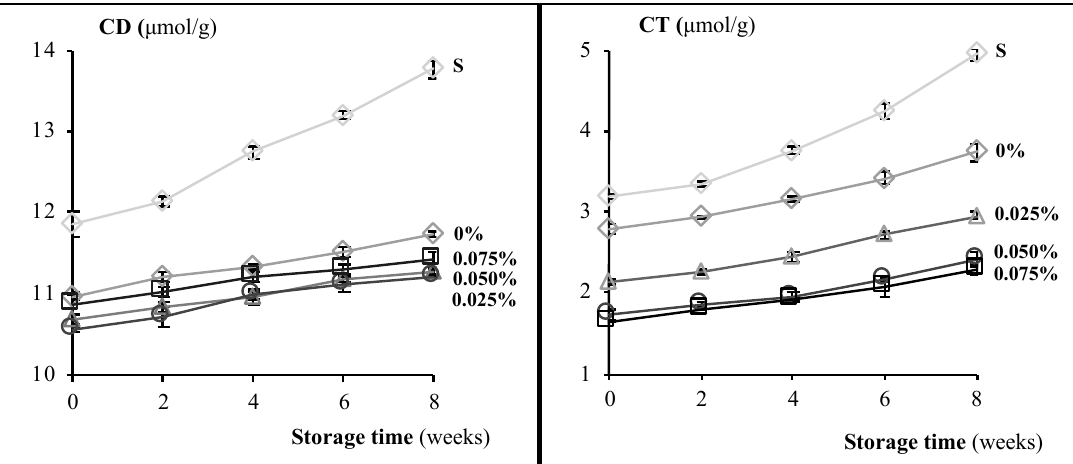
Figure 3. Conjugated diene (CD; μ mol/g fat) and conjugated triene (CT; μ mol/g fat) content in muffins differing in ChPE (chokeberry polyphenol extract) content (0–0.075%) and in muffins containing sucrose (S) during storage (0–8 weeks).